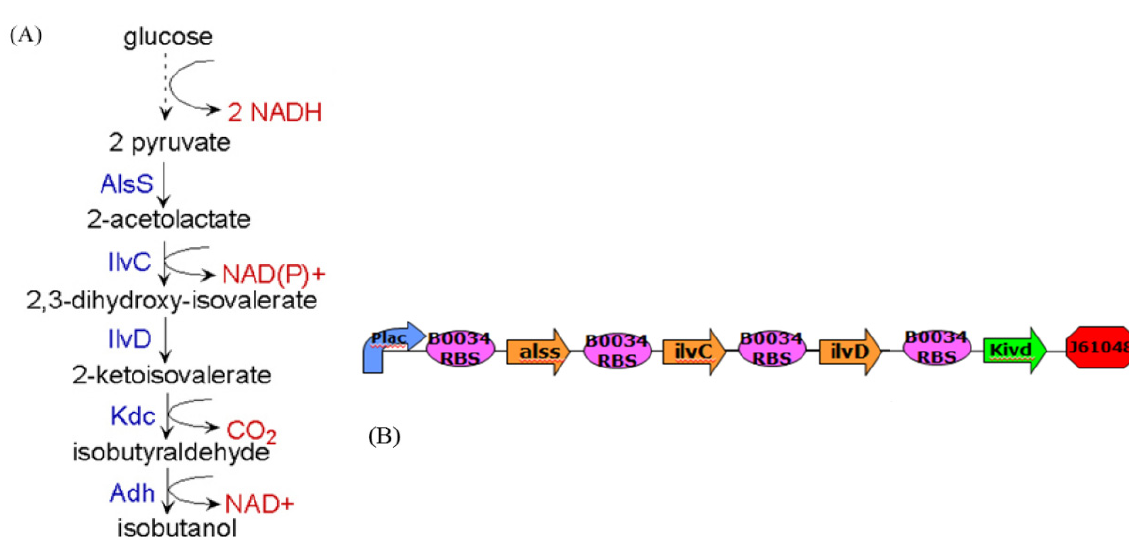
Figure 14. Engineered synthetic metabolic pathway for isobutanol production in E. coli . ( A ) Schematic representation of engineered isobutanol production pathway. ( B ) Engineered synthetic genetic circuit to generate the enzymes necessary for pathway in ( A ) for isobutanol production in E. coli